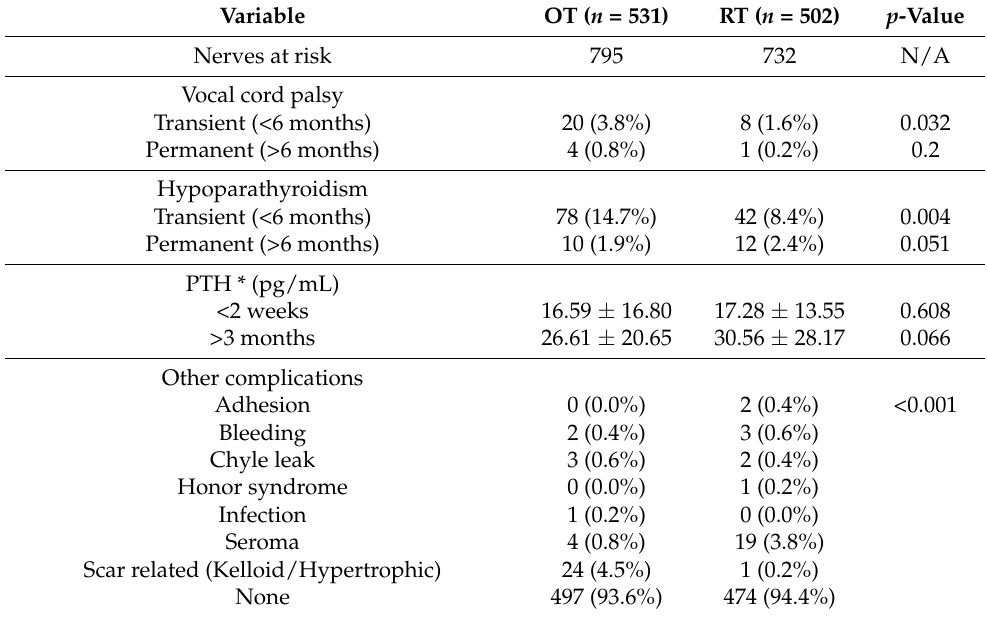
Table 4. Postoperative